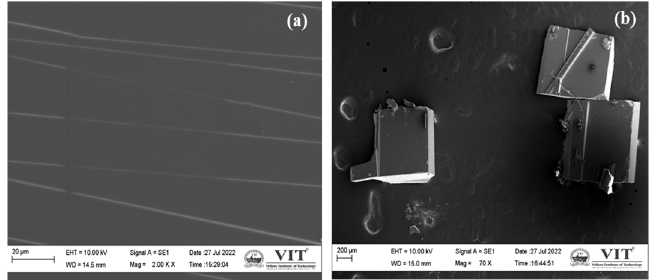
Figure 13. ( a , b ) 20 µm and 200 µm SEM micrograph of grown MMPI